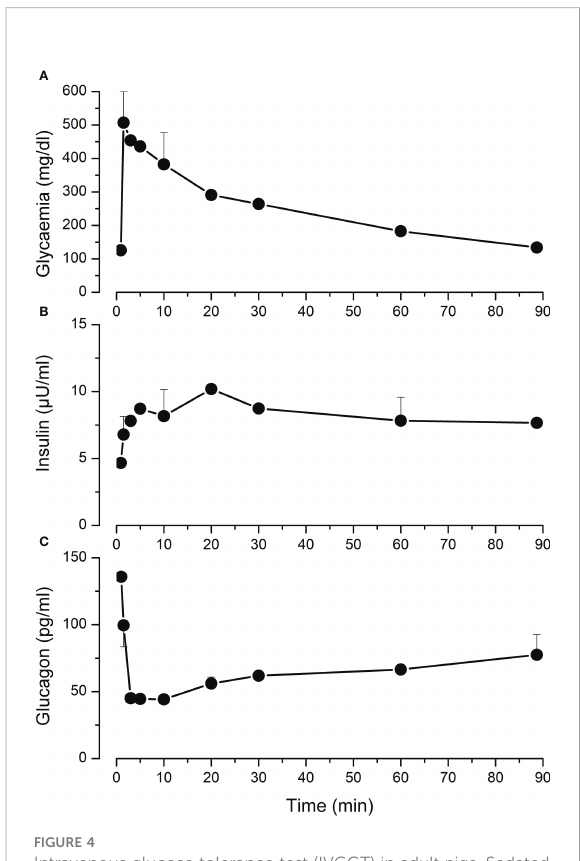
FIGURE 4 Intravenous glucose tolerance test (IVGGT) in adult pigs. Sedated fasting animals received an intravenous glucose bolus (0.5 g/Kg) at t=0. Blood samples were taken before and during 90 minutes after the injection to measure glycaemia (A) , insulin (B) and glucagon (C) . Values are means ± SEM from n=4 adult